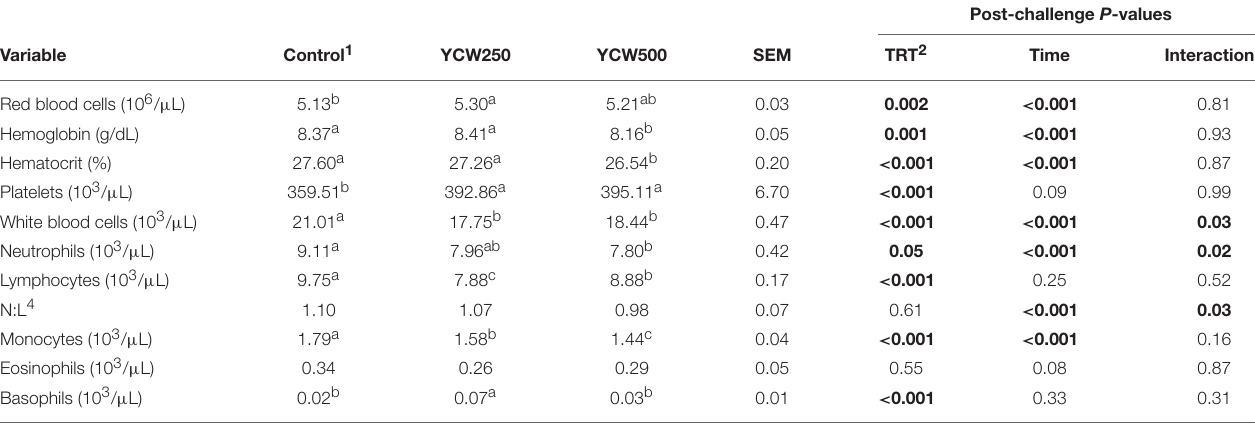
TABLE 5 | Complete blood cell count parameters measured in pigs fed a control (Control) diet or supplemented with a yeast cell wall at 250 mg/kg (YCW250) or 500 mg/kg (YCW500), following administration of an oral Salmonella Typhimurium challenge on d 19.